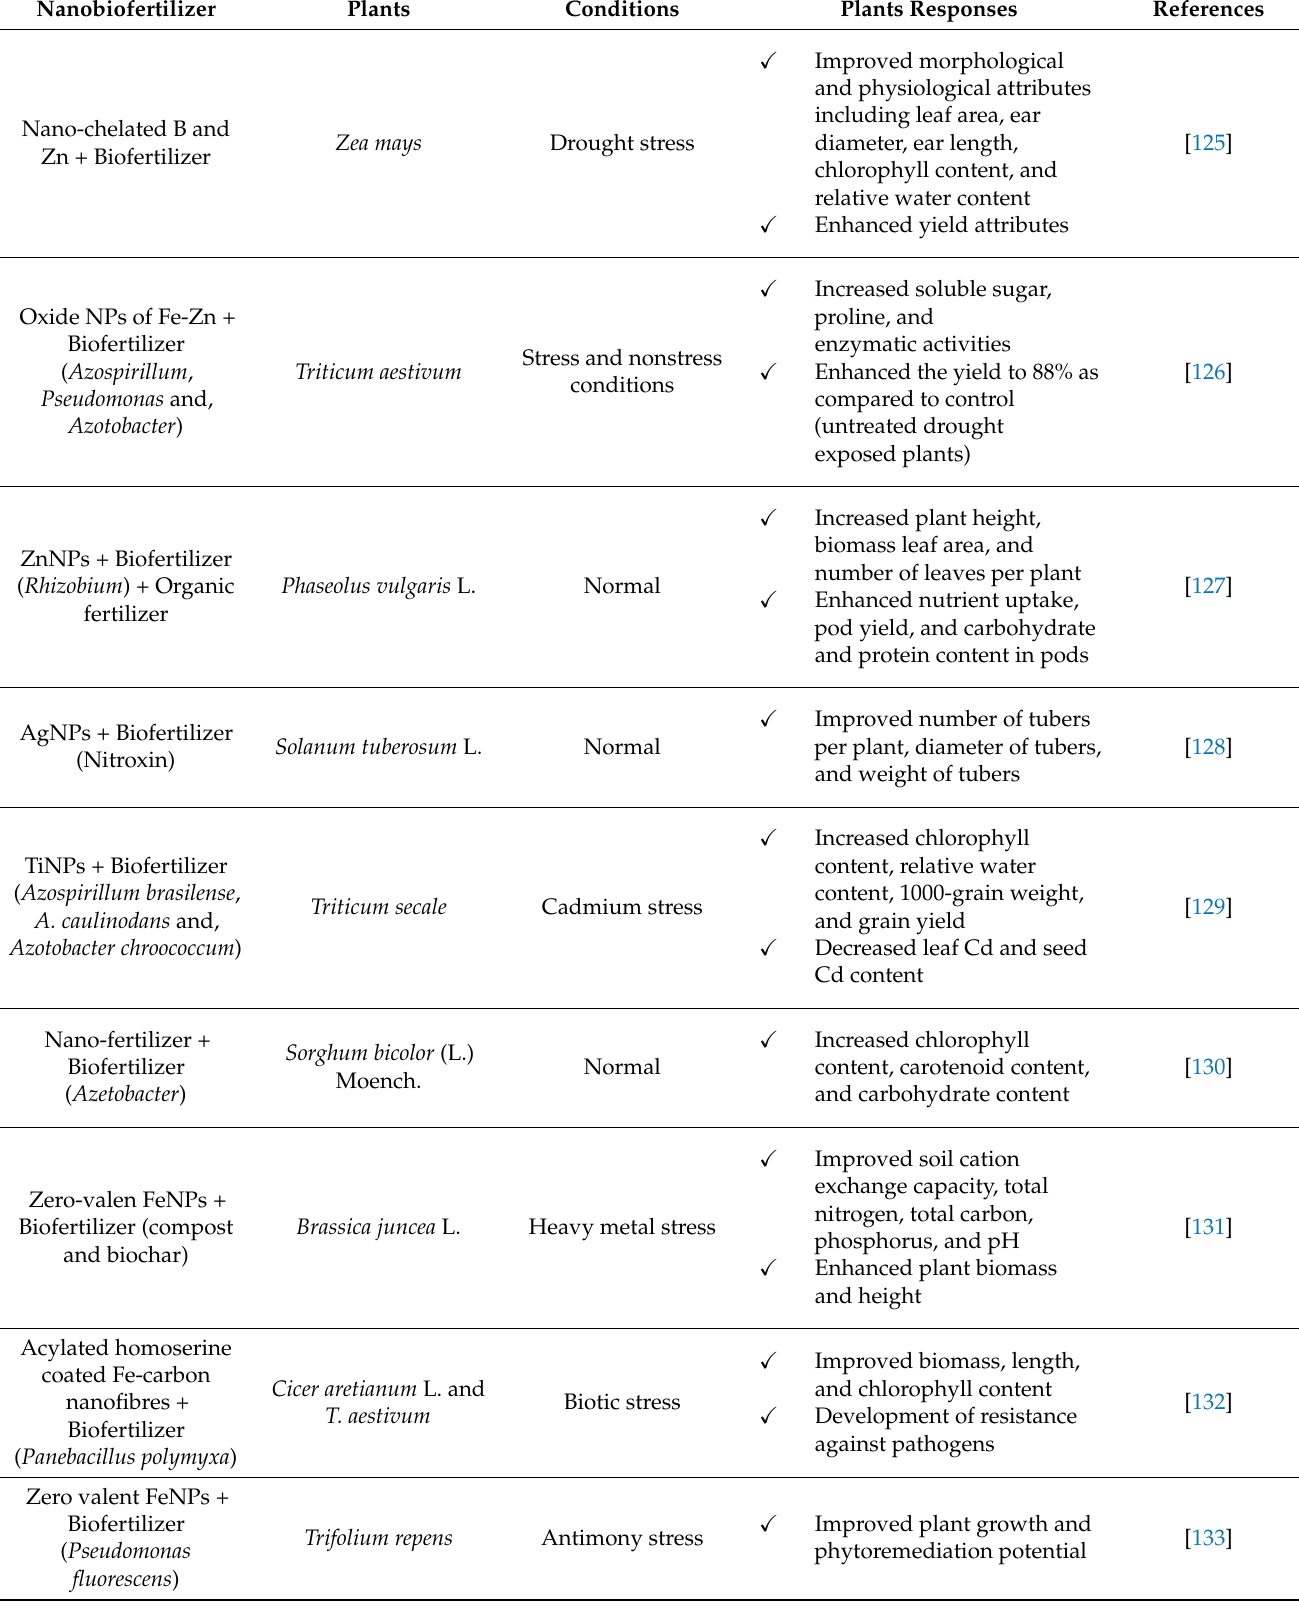
Table 2. Role of nanobiofertilizer in different plants under control and stressed